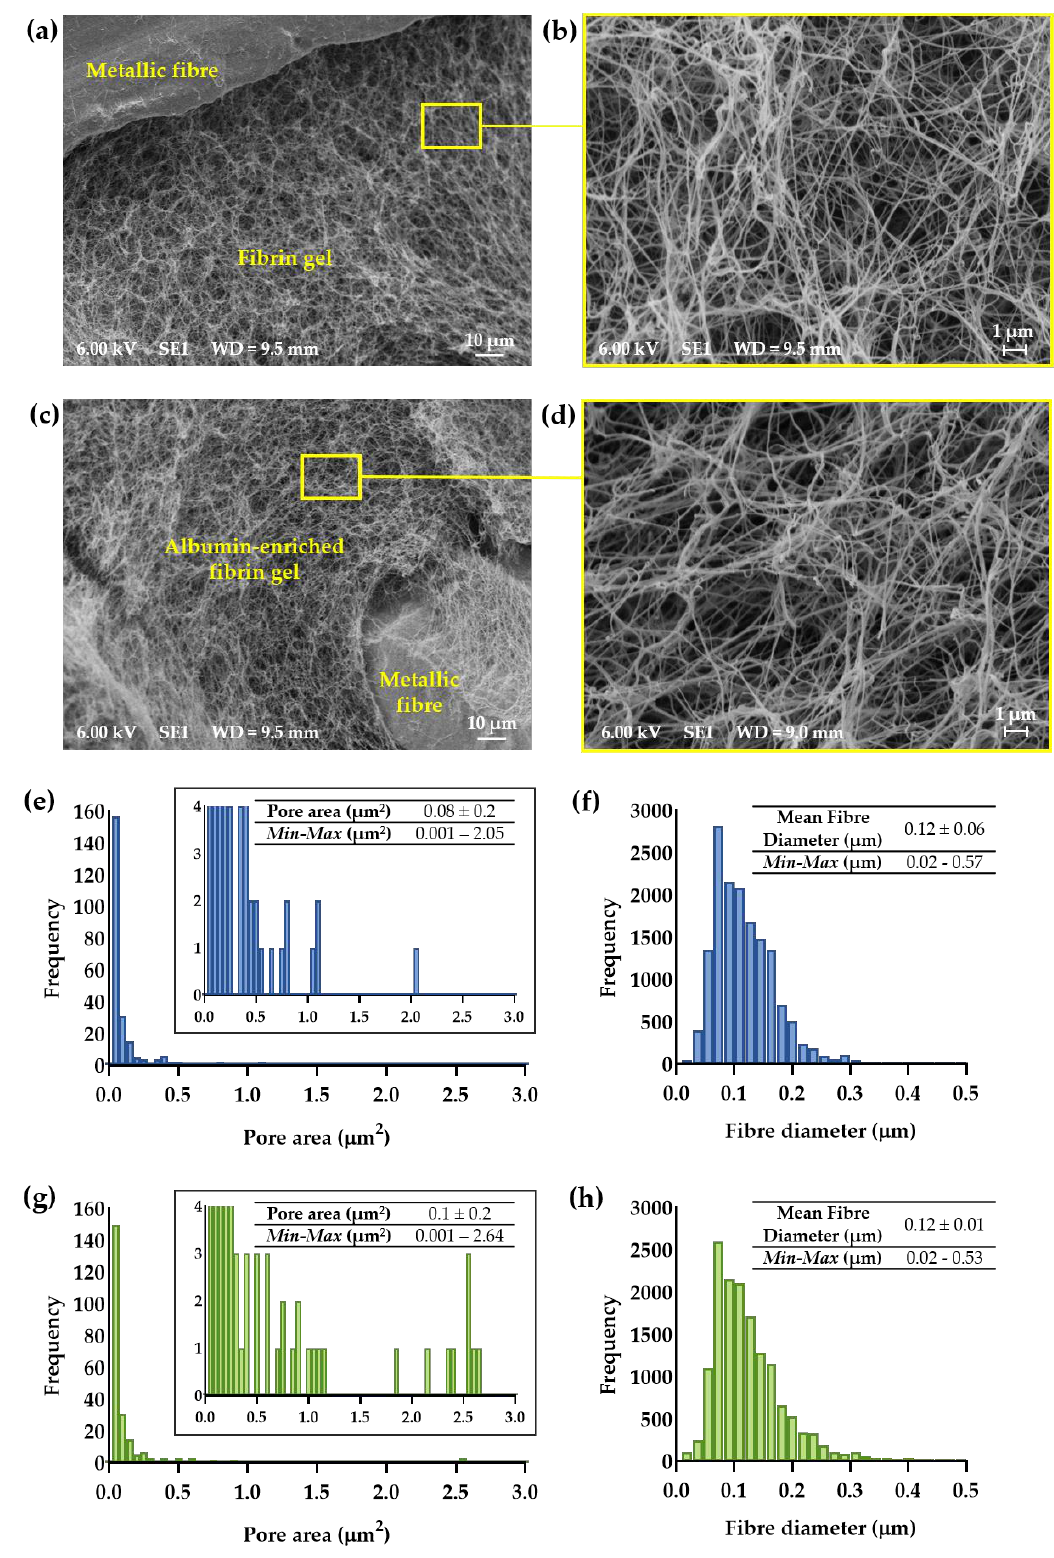
Figure 2. Typical scanning electron micrographs showing top views of 444 networks impregnated with ( a , b ) fibrin (444_F) and ( c , d ) albumin-rich fibrin (444_AF) hydrogels; Distributions of pore area and fibre diameter for: ( e , f ) 444_F and ( g , h ) 444_AF as measured by DiameterJ ( n = 3 samples from each group and five randomly selected areas from each sample).